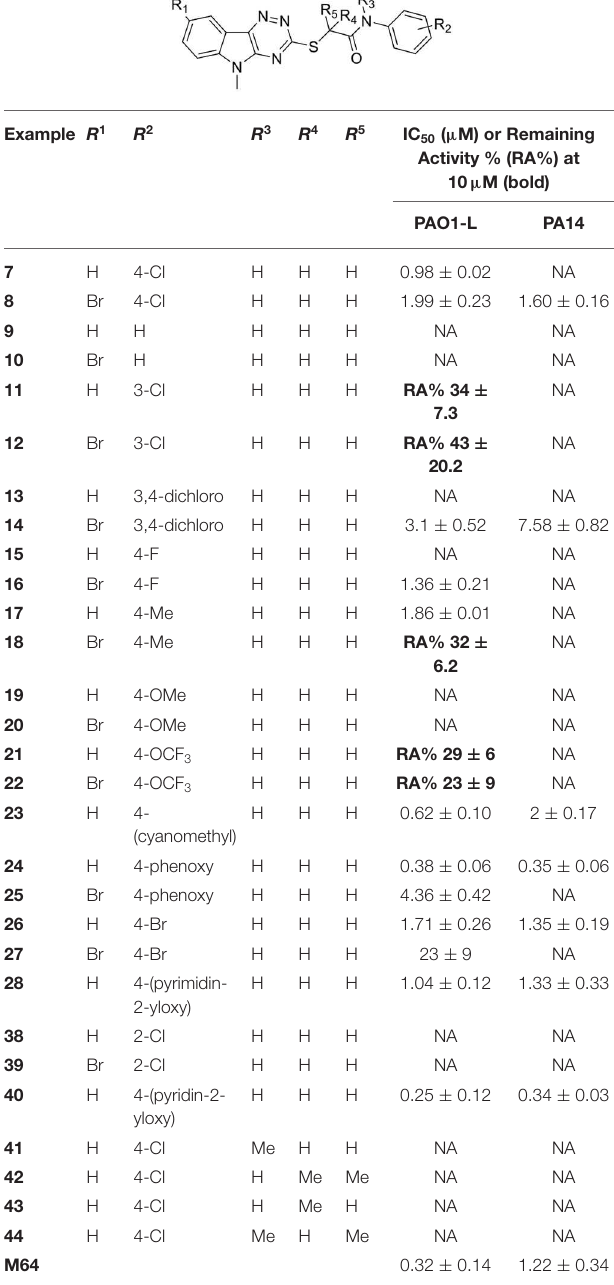
TABLE 1 | Pseudomonas aeruginosa P pqsA -lux bioreporter assays of the compounds synthesized.